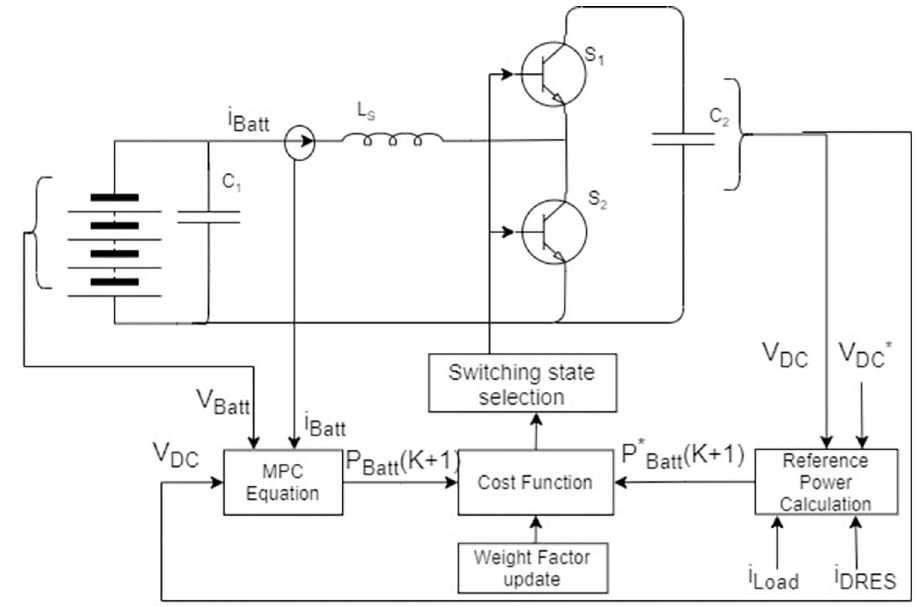
Fig 7. MPC block diagram for GFM operation through DC/DC